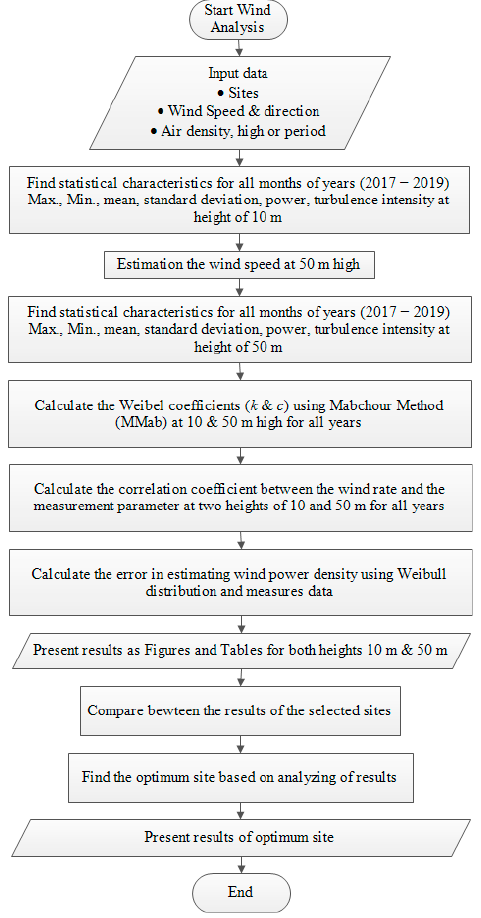
Figure 2. The flowchart of the developed approach to analyze the wind in Iraq.